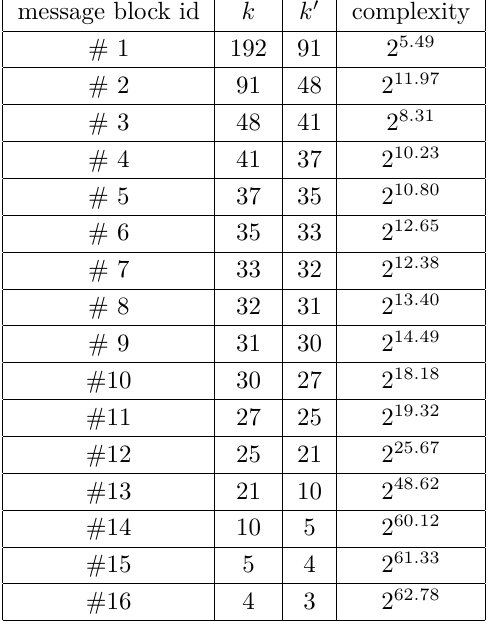
Table 5: A possible iterating process of 3-round Keccak-256 via Iterating Strategy and 5-for-3 Strategy